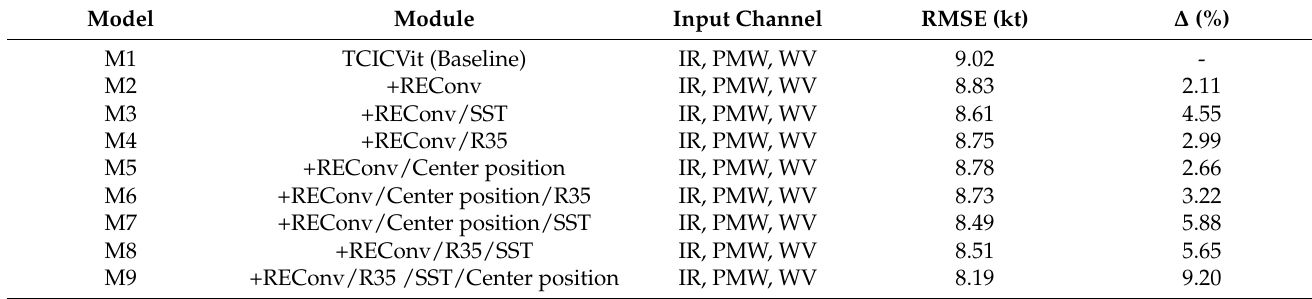
Table 7. Same as Table 5 but for fusion of IR, PMW, and WV remote sensing